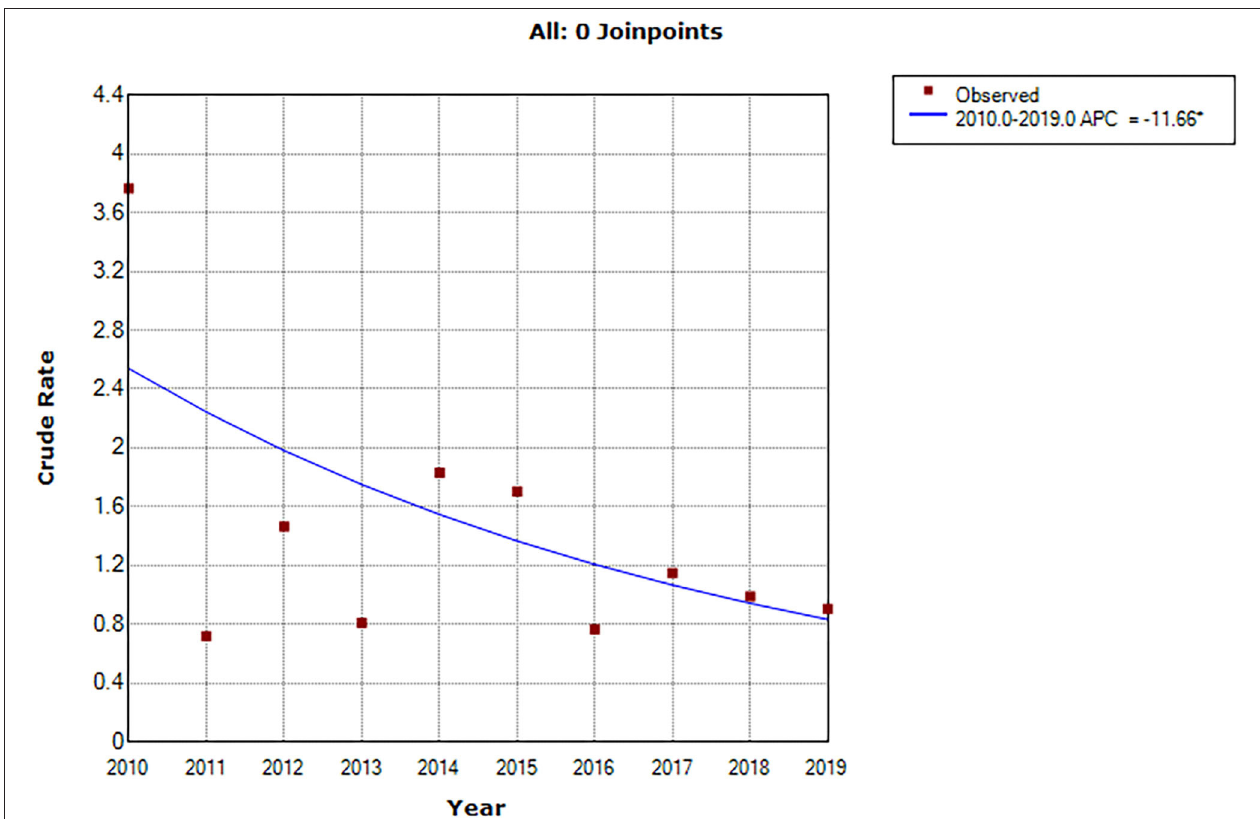
FIGURE 1 | APC of crude SUDEP incidence rate in 2010–2019. *Indicates that the Annual Percent Change (APC) is significantly different from zero at the alpha = 0.05 level. Final Selected Model: 0 Joinpoints.